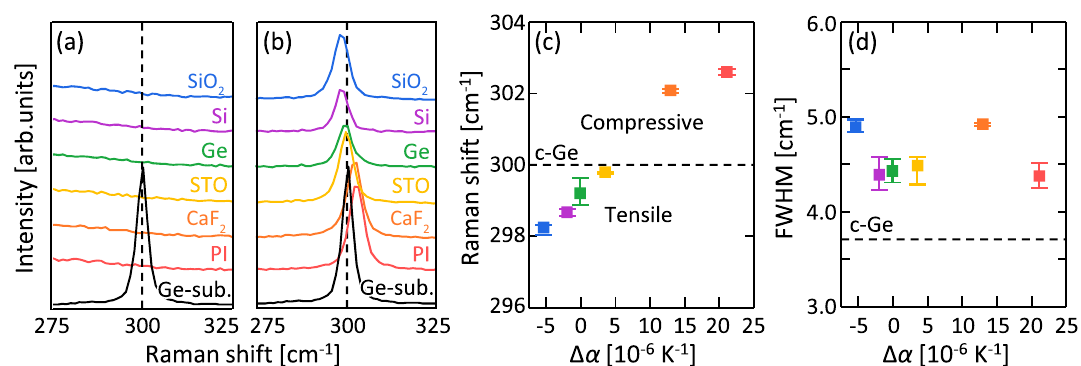
Figure 1. Raman spectroscopy analysis of the Ge layers on various substrates. ( a , b ) Raman spectra of the samples ( a ) before and ( b ) after annealing; the spectrum of a single-crystal Ge (100) wafer is shown for comparison. ( c ) Raman shifts and ( d ) FWHMs of the Ge peaks as functions of Δ α ; the values for the Ge wafer are shown by the dotted lines. The error bars indicate the variability in the Raman measurements at five locations for each 1-cm square Table 1. Before the thin film deposition, the substrates were cleaned with acetone, methanol, and distilled water. To eliminate the difference in the interface between Ge and substrate, we fabricated 50-nm-thick GeO x layers on the substrates using radio-frequency (RF) magnetron sputtering (base pressure: 3.0 × 10 –4 Pa) with 10 sccm Ar plasma (working pressure: 0.5 Pa), where the RF power was set to 50 W. The sample stage was not heated or rotated. The samples were then air-transferred from the sputtering chamber to a molecular beam deposition system (base pressure: 5 × 10 −7 Pa) within five min to avoid the reaction of GeO x with air. Subsequently, 400-nm-